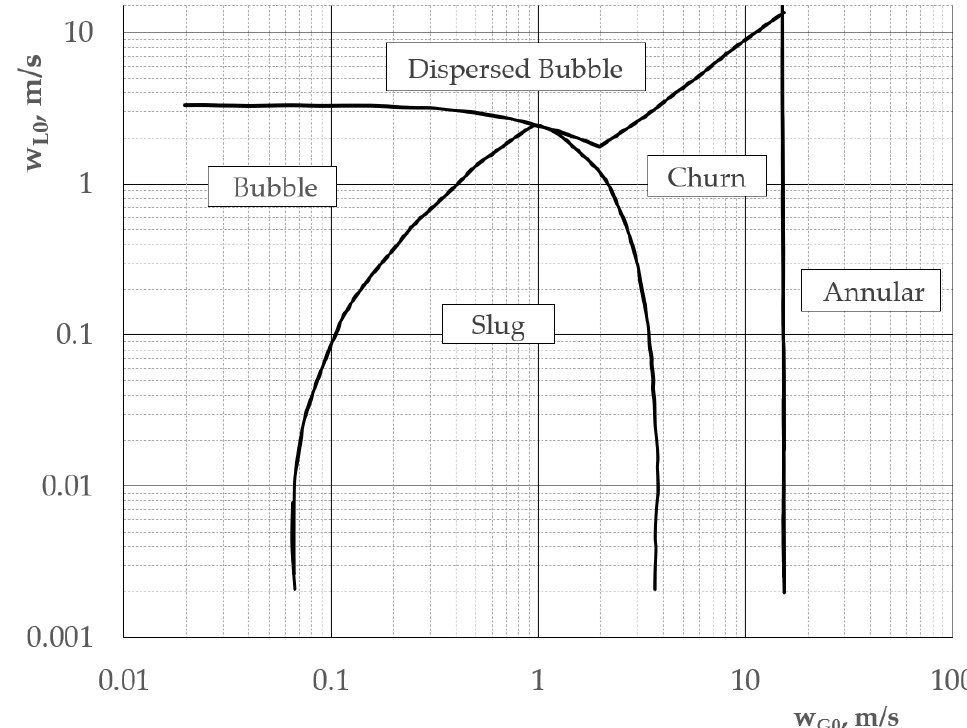
Figure 1. Two-phase flow map according to Titel [45] for vertical pipe with the areas of flow patterns indicated.